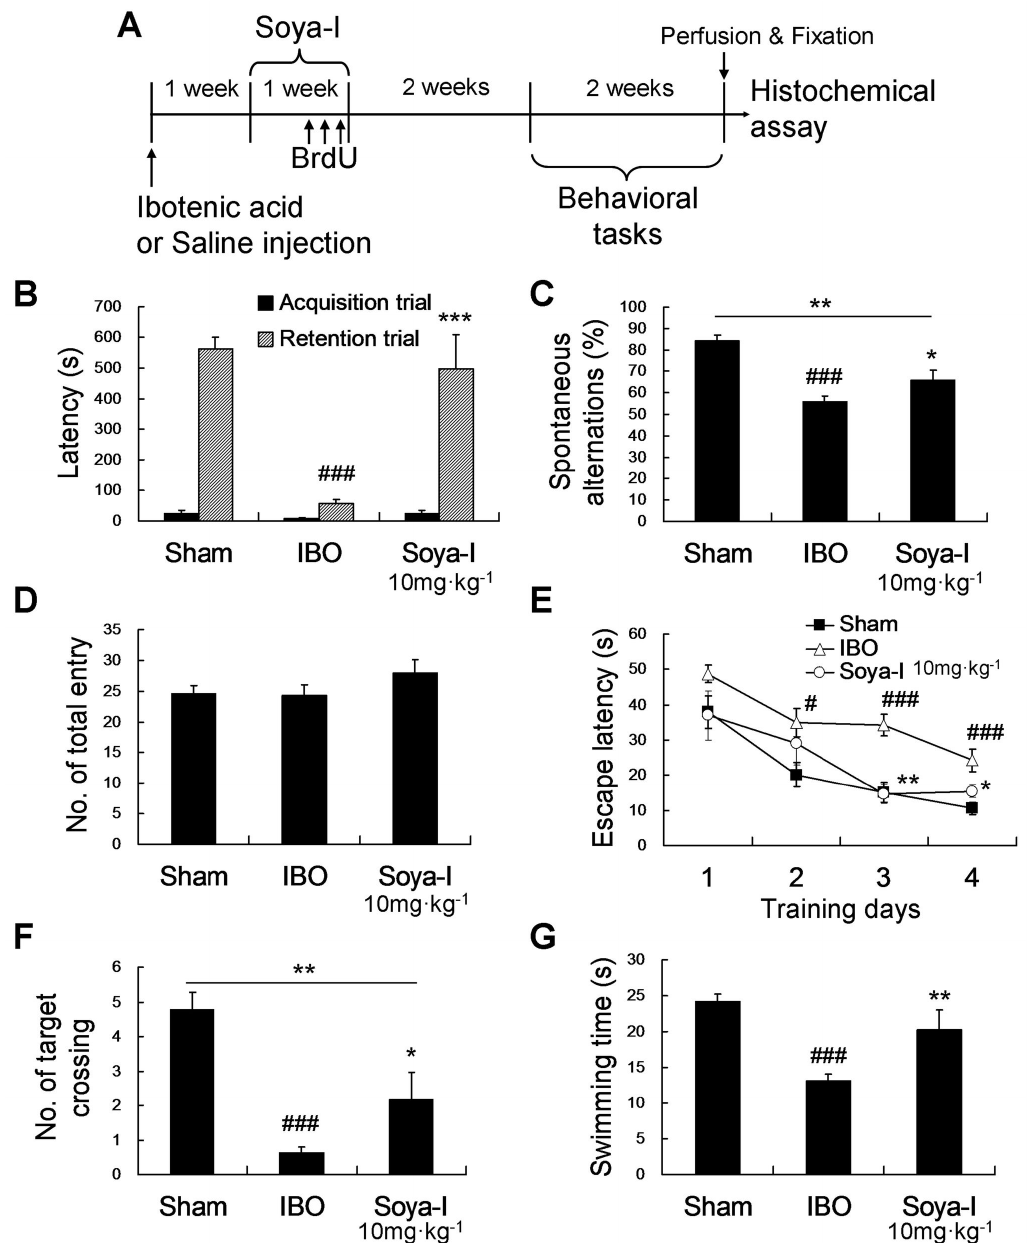
Figure 4. Effects of soya-Ι on behavioral tests 4 weeks after soya-I administration in memory-deficient rats. A. A time line of experimental procedures B. Behavioral effect of soya-I on memory-deficient model rats 4 weeks after oral administration. Rats were orally administered soya-Ι (10 mg·kg -1 , p.o.) or vehicle (same volume, p.o.) once per day for 7 days, and passive avoidance tests (B) and Y-maze tests (C) were carried out 3 weeks later. The sham group was injected with saline instead of IBO. B. Latency times in passive avoidance test and C. spontaneous alterations in the Y-maze test during 8-min sessions were measured as described in Materials and Methods. Rats were orally administered soya-Ι (10 mg·kg -1 , p.o.) or vehicle (same volume, p.o.) once per day for 7 days, and the Morris water maze task was carried out 3 weeks later. The sham group was injected with saline instead of IBO. D. Total entries were not significantly different. E. The mean escape latency to find the hidden platform during 4 consecutive days of training trials, F. the number of virtual platform crossings and G. swimming time in the target quadrant in 60-s probe trials with no platform were measured as described in Materials and Methods. Closed square = Sham group, opened triangle = IBO group, open circle = soya-I treated group. Data represent means ± SEM ( # p < 0.05, ## p < 0.01, ### p < 0.001, compared with the sham group, * p < 0.05, ** p < 0.01, *** p < 0.001, compared with the IBO group by the Newman-Keuls Multiple Comparison Test). doi: 10.1371/journal.pone.0081556.g004 PLOS ONE |